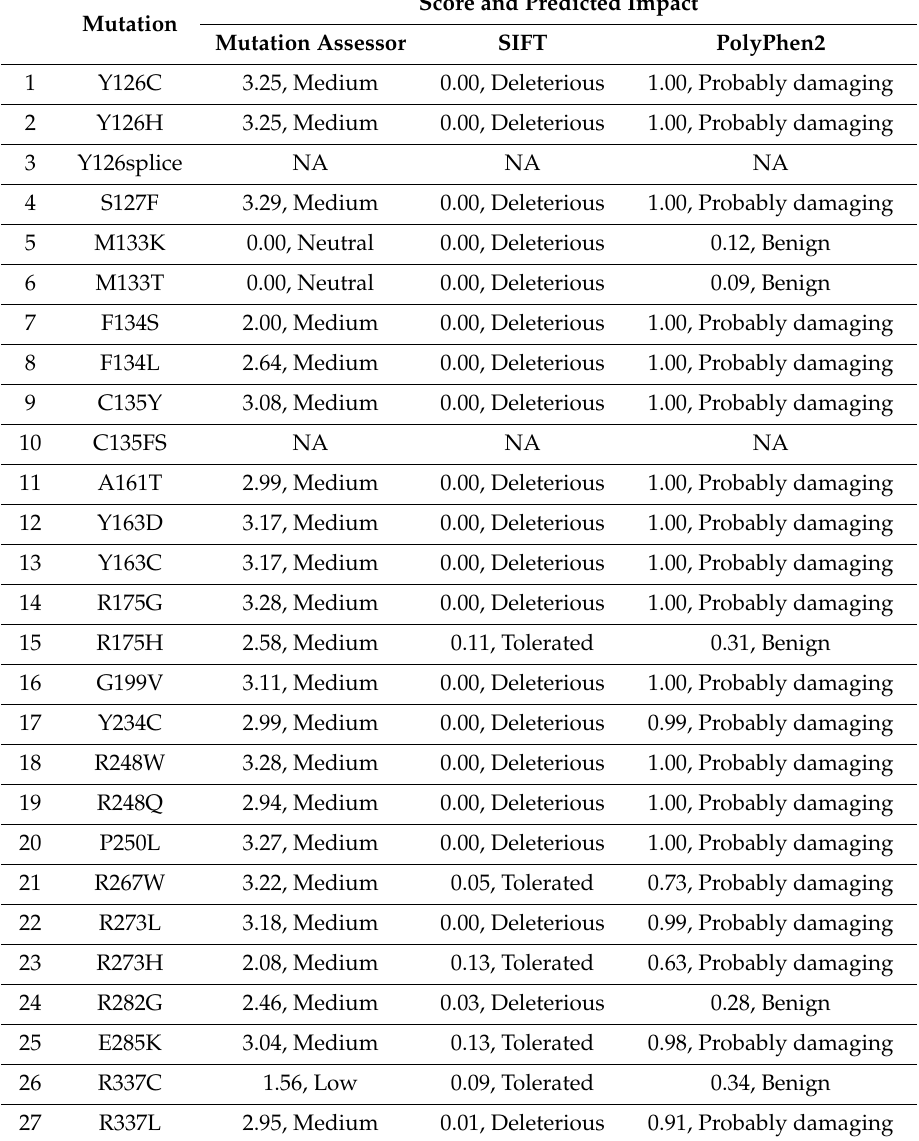
Table 3. In Silico Predicted Functional Consequence of TP53 Mutations in MM 1